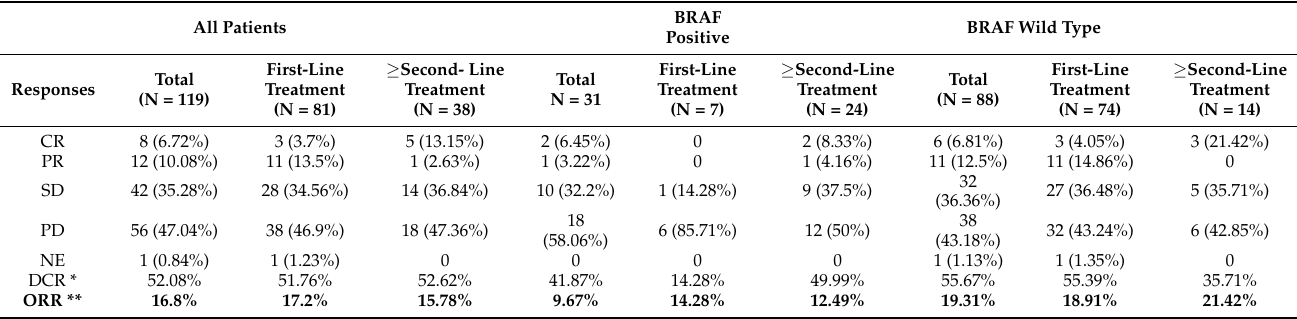
Table 3. Response rates to nivolumab or